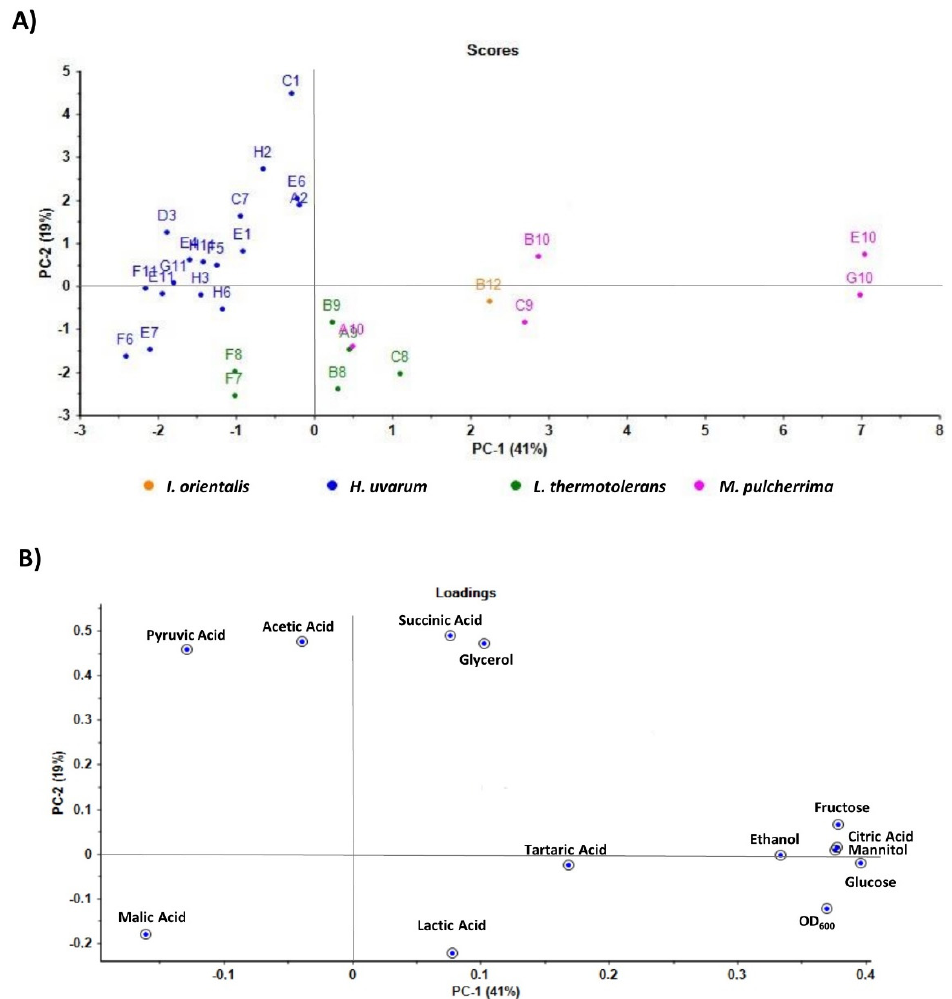
Figure 5. Principal component analysis (PCA) plot based on the metabolite characterization for the selected non- Saccharomyces species isolated from Port wine must samples. PCA score plot ( A ) and loading plot ( B ) in terms of Principal Component 1 (PC 1, x-axis) and Principal Component 2 (PC 2, y-axis) was performed with metabolite quantification results, including ethanol production rate, glucose and fructose consumption, glycerol, mannitol, and organic acids quantification, for selected non- Saccharomyces species isolated from Port wine must samples. Singular Value Decomposition (SVD) with imputation was used to calculate principal components.